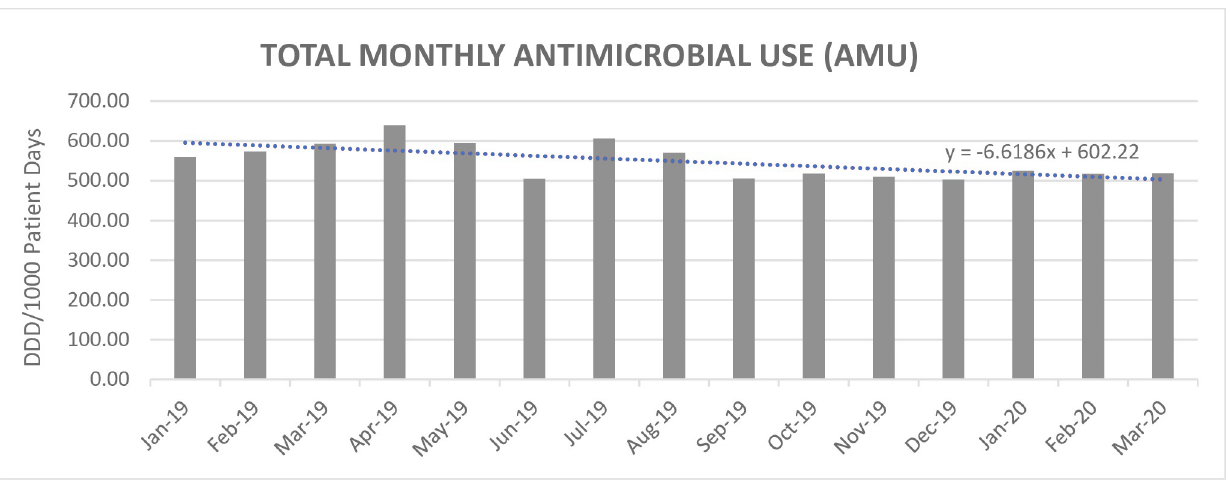
Fig 1. Total antimicrobial